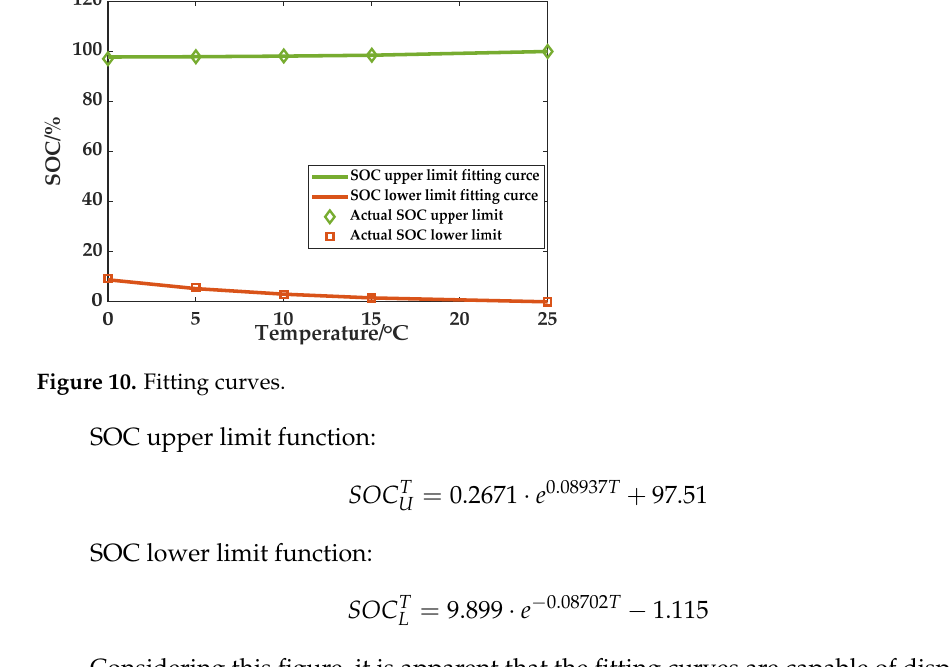
Figure 9. Upper and lower limits of SOC at different temperatures. The upper and lower limits of the SOC function can be acquired by curve fitting in accordance with the determined upper and lower limits of SOC at four temperatures. Based on the results of the fitting, the two limits of the SOC at other temperatures, such as 0 ◦ C, can be simulated. The fitting curves are shown in Figure 10.